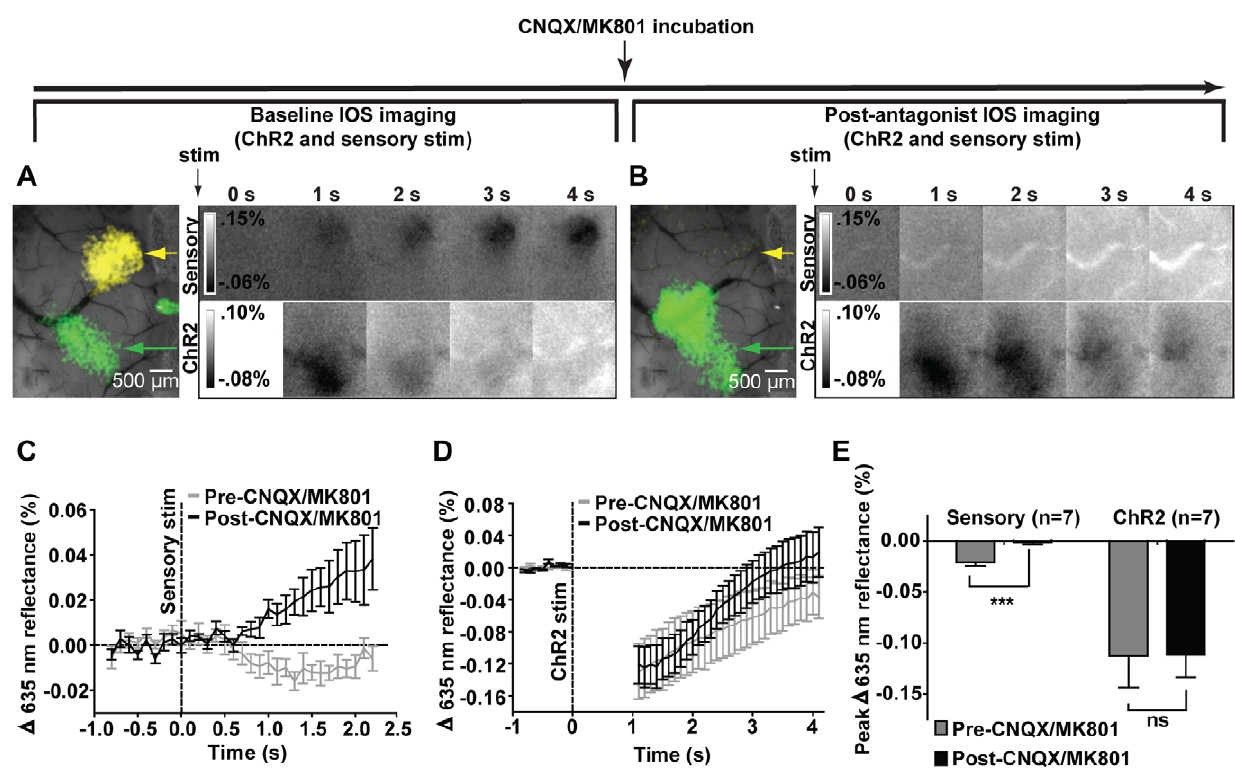
Figure 3. Blockade of synaptic transmission by CNQX and MK801 inhibits forepaw stimulation responses but not ChR2. A, left : Pre- antagonist IOS responses to sensory stimulation (yellow, indicated by yellow arrow) and ChR2 stimulation (green, indicated by green arrow) thresholded to 50% of maximum and superimposed on an image of the cortical surface. Right : Temporal evolution of IOS responses to 1 s of sensory stimulation ( upper ) and ChR2 stimulation ( lower ). B, left : Post-antagonist IOS response to sensory stimulation is inhibited (yellow arrow indicates pre- antagonist map location), while the IOS response to ChR2 stimulation is preserved (green, indicated by green arrow). Right : Temporal evolution of IOS responses to 1 s of sensory stimulation ( upper ) and ChR2 stimulation ( lower ). A,B Shown are the averaged results of 20 trials from a representative animal; blanked data at 0 s represents stimulus artifact. C, Temporal profiles of IOS responses to 1 s of sensory stimulation before and after CNQX/ MK801 incubation (n=7); responses are displayed until pre-CNQX/MK801 responses return to baseline. D, Temporal profiles of IOS responses to 1 s of ChR2 stimulation before and after CNQX/MK801 incubation (n=7); blanked data indicate laser stimulus artifact. C,D Stimulus onset denoted by vertical dotted line. E, Peak amplitudes in sensory-evoked IOS responses were significantly reduced following antagonist incubation (paired t -test, p=0.0009) while peak ChR2-evoked IOS responses were not (paired t -test, p=0.9358). Error bars represent SEM.